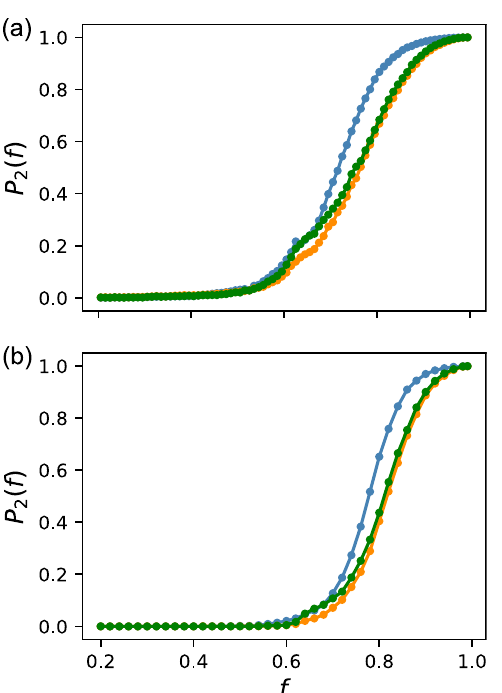
Fig 6. Fitness dependence of the fraction of bistable GRNs. The blue line represents random sampling. The orange and green lines represent Evo50 and Evo90, respectively. The standard errors are smaller than the mark. Bistability was checked as follows. First, starting from the steady state at I = 0, I increased by Δ I , and the dynamics were run until a steady state was reached. This procedure was repeated for up to I = 1. Then, the inverse process, from I = 1 to 0, was performed. If the difference in � x larger than the threshold x th was observed between these two processes in a range of out I , the GRN was regarded as bistable. GRNs obtained by ES were classified according to f into 100 bins, similar to random sampling. (a) Strict criterion, Δ I = 0.001 and x = 10 − 6 . (b) Loose criterion, Δ I = 0.01 and x = 0.5. th th